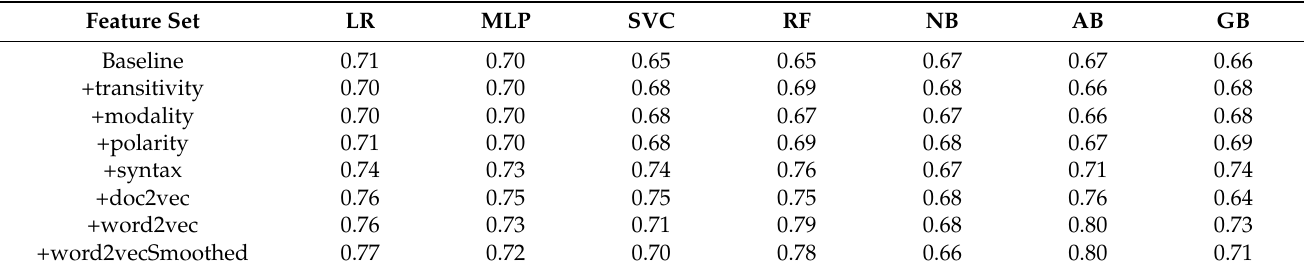
Table 2. Classification of solutions from non-solutions using ML classifiers by training data iteration.